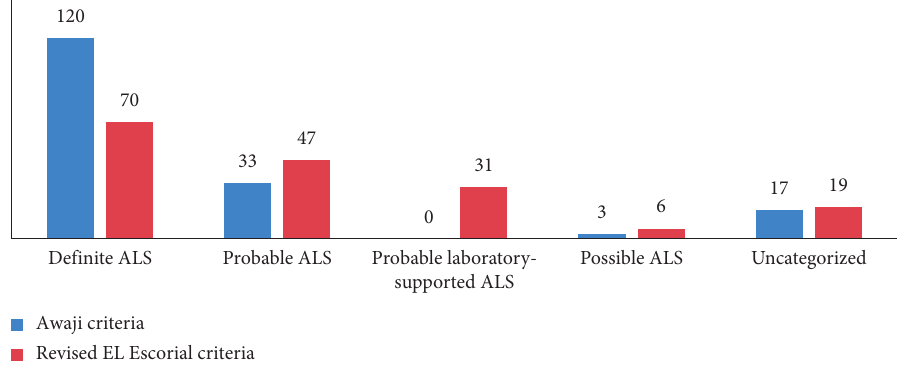
Figure 1: Diagnostic categories for the entire cohort of ALS patients, according to the AC and rEEC.